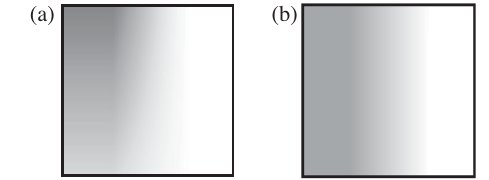
FIG. 8. (a) Given a “ rotated ” distribution p θ , as shown above in Fig. 5(a), the decorrelated distribution ϕ C ð p θ Þ , as in Eq. (70). (b) The decorrelated and twirled distribution ϕ G ½ ϕ C ð p θ Þ(cid:2) .